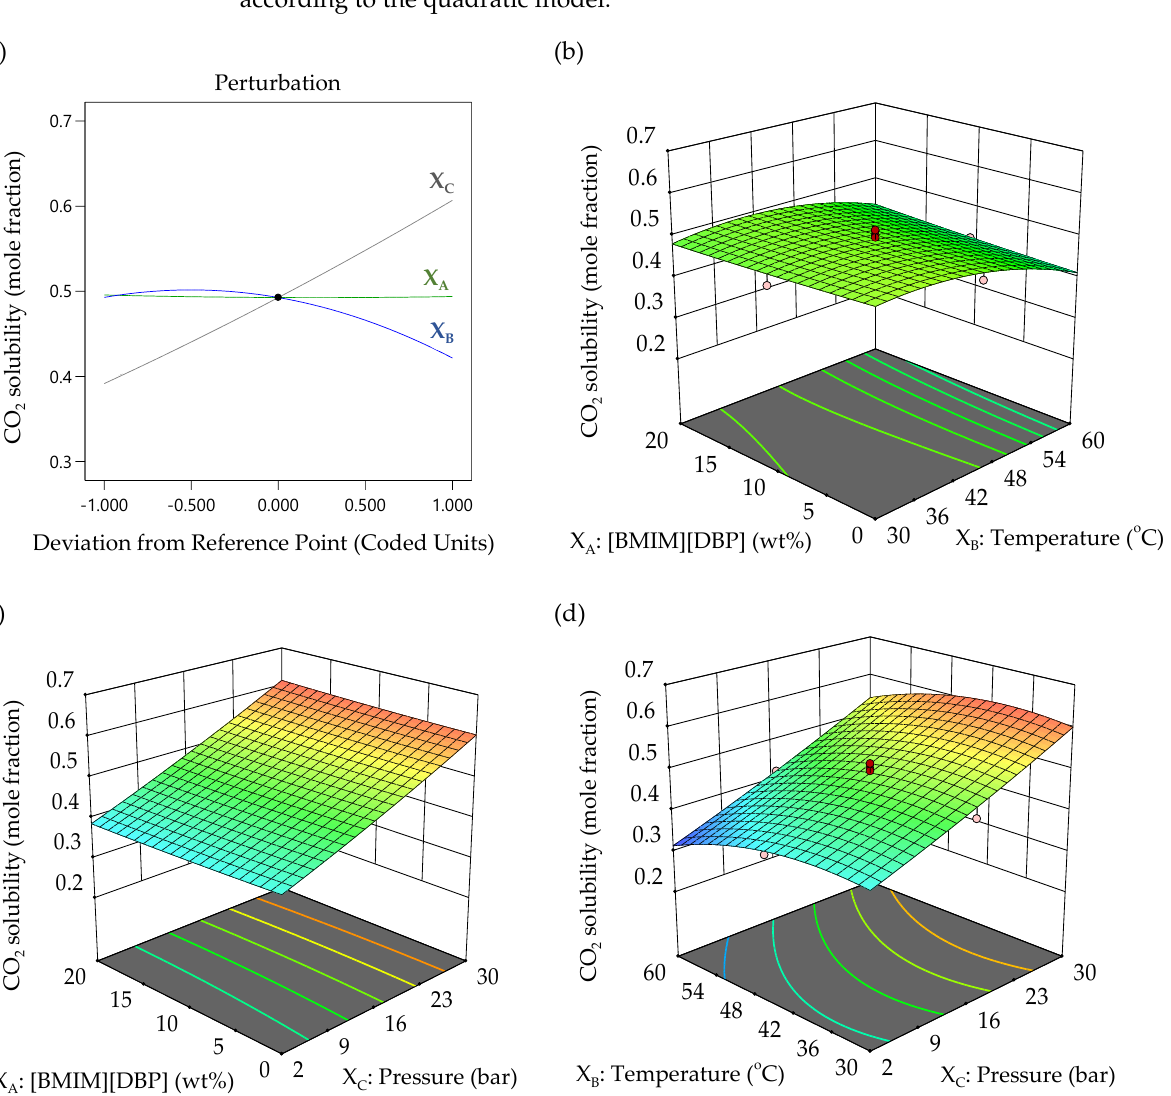
Figure 6. ( a ) Perturbation plot showing the effect of variable factors on CO 2 solubility and the response surface plots of CO 2 solubility as a function of ( b ) (BMIM)(DBP) concentration and temperature, at a pressure of 16 bar ( c ) (BMIM)(DBP) concentration and pressure at a temperature of 45 °C, and ( d ) temperature and pressure at a 10 wt% (BMIM)(DBP) concentration.